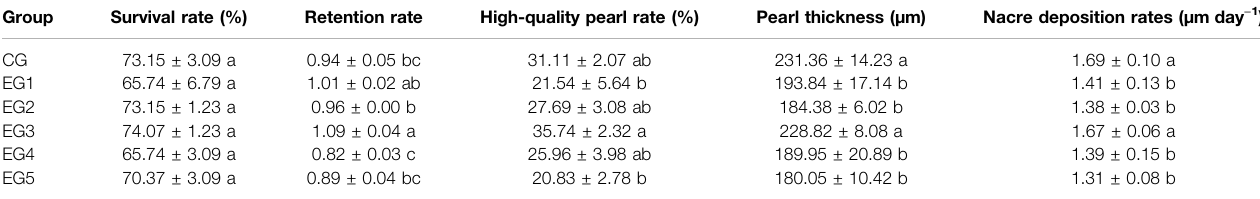
Within the column, means with the same letters are not signi fi cantly different ( p > 0.05).